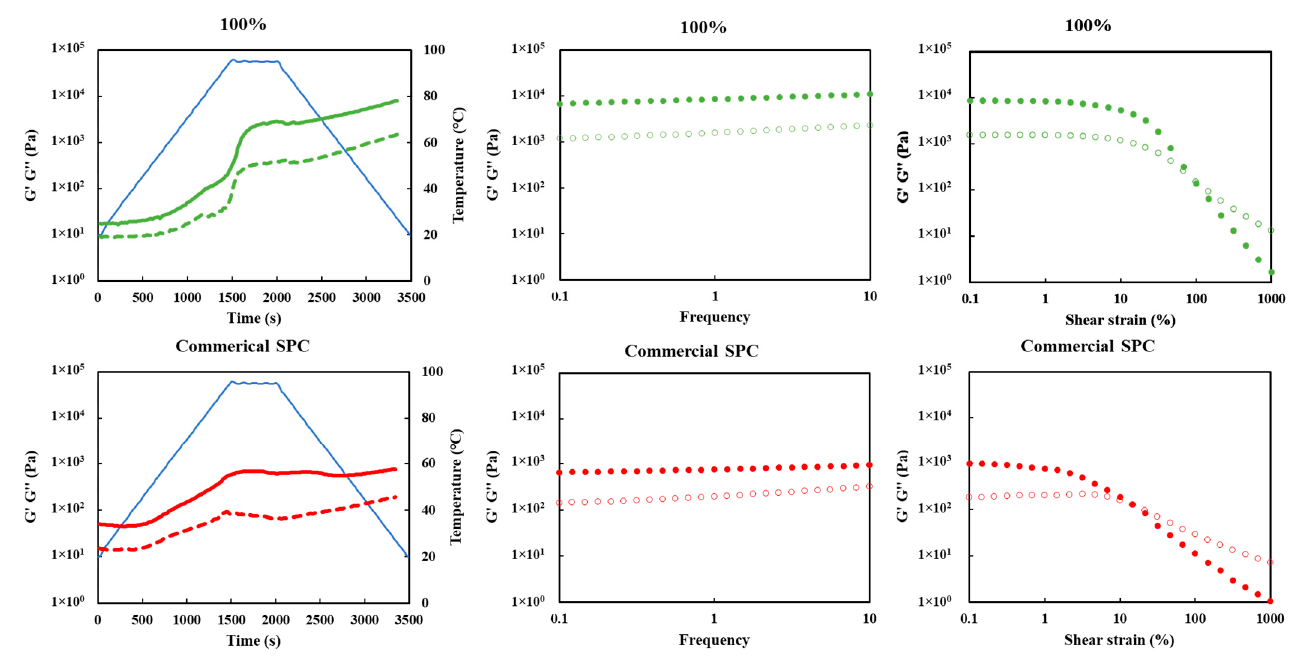
Figure 10. Temperature ( left ), frequency ( middle ), and strain ( right ) sweeps sequentially applied on all the soy protein concentrate (SPC) samples (standardized 9 wt% protein content). G’, closed symbols; G’’, open symbols; temperature, solid blue line.